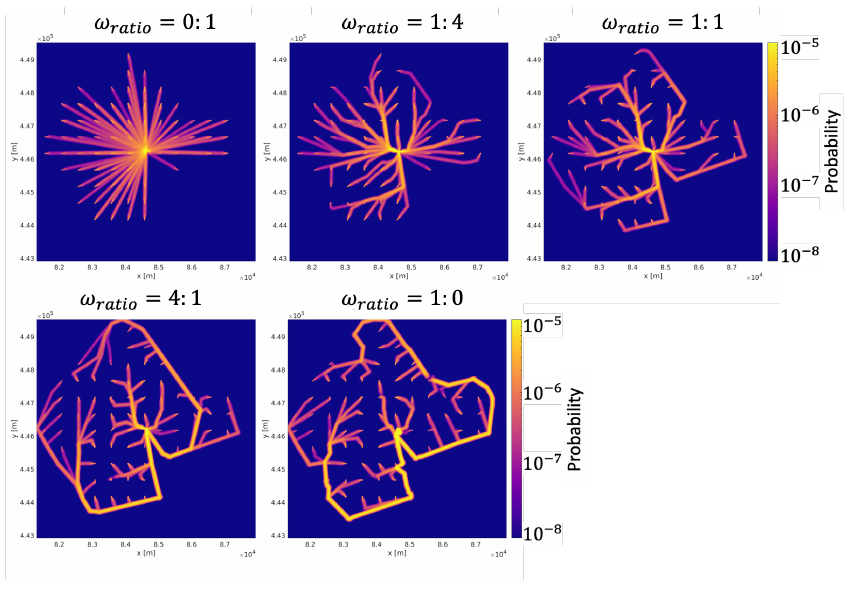
Figure 6. Annual IR with different risk weight